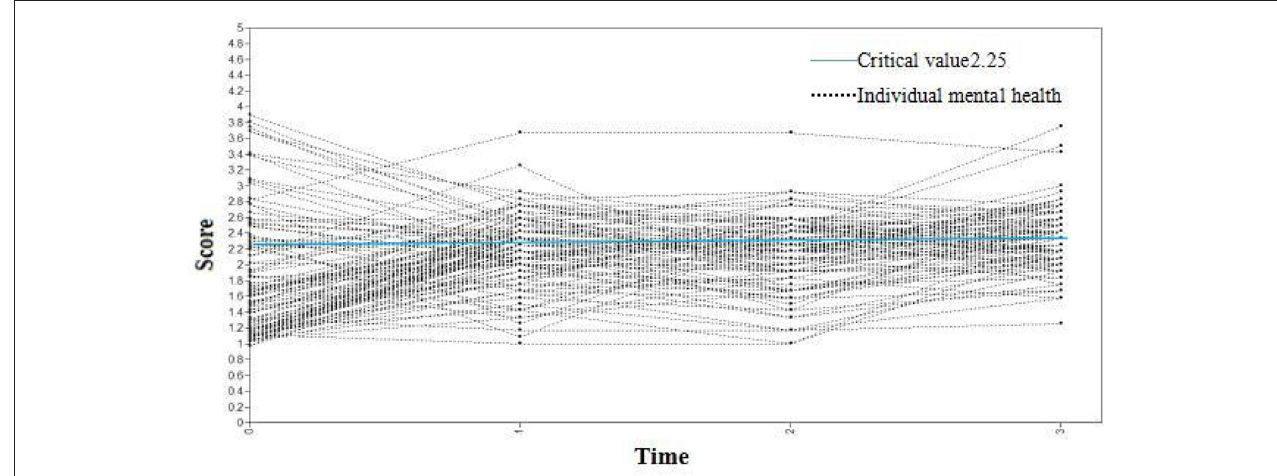
FIGURE 2 | The changing trajectory of mental health status of medical staff at four different observation times.